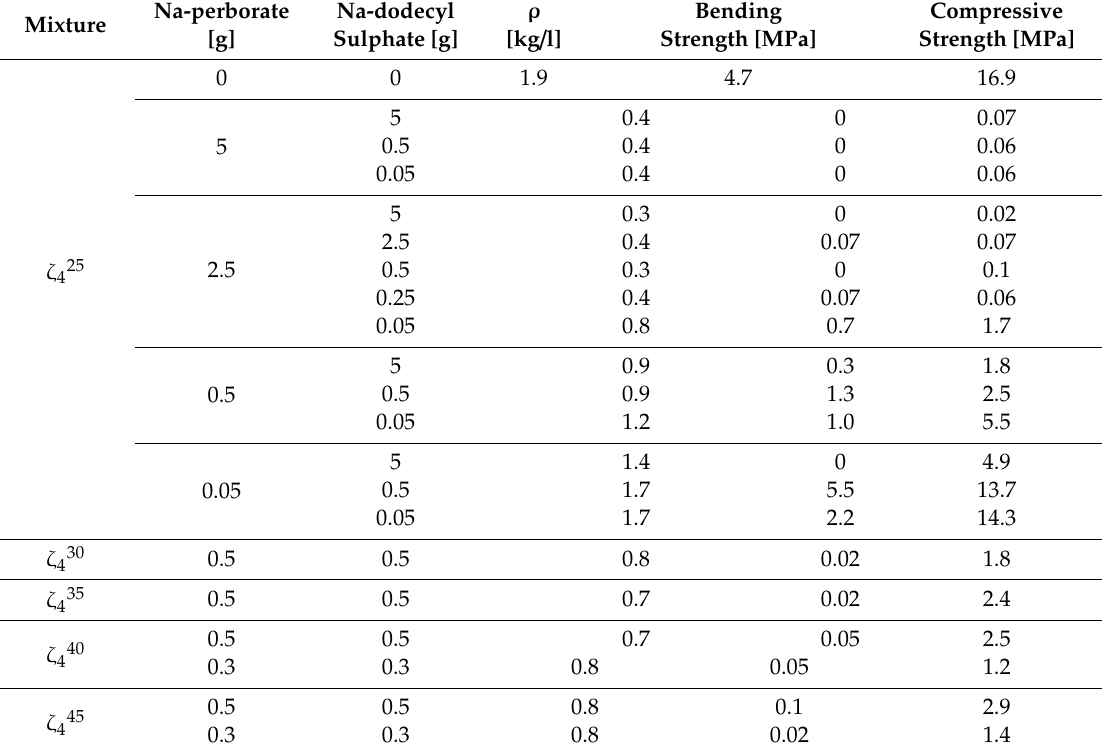
Table 16. Density, bending, and compressive strength of AAF, produced by Na-perborate using mixture ◦ C for one day, measured one week after molding. Combination of ingredients for AA ζ 4 , cured on 70 resulting in literature’s highest compressive strength value is